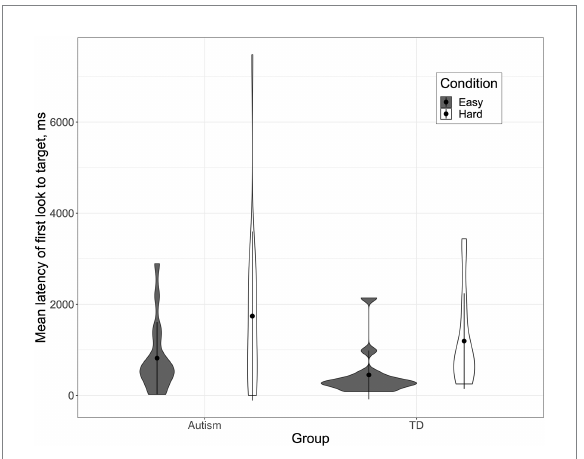
the target, in ms, by group and condition. The black dot indicates the mean, and the shape indicates the probability density of the data at different